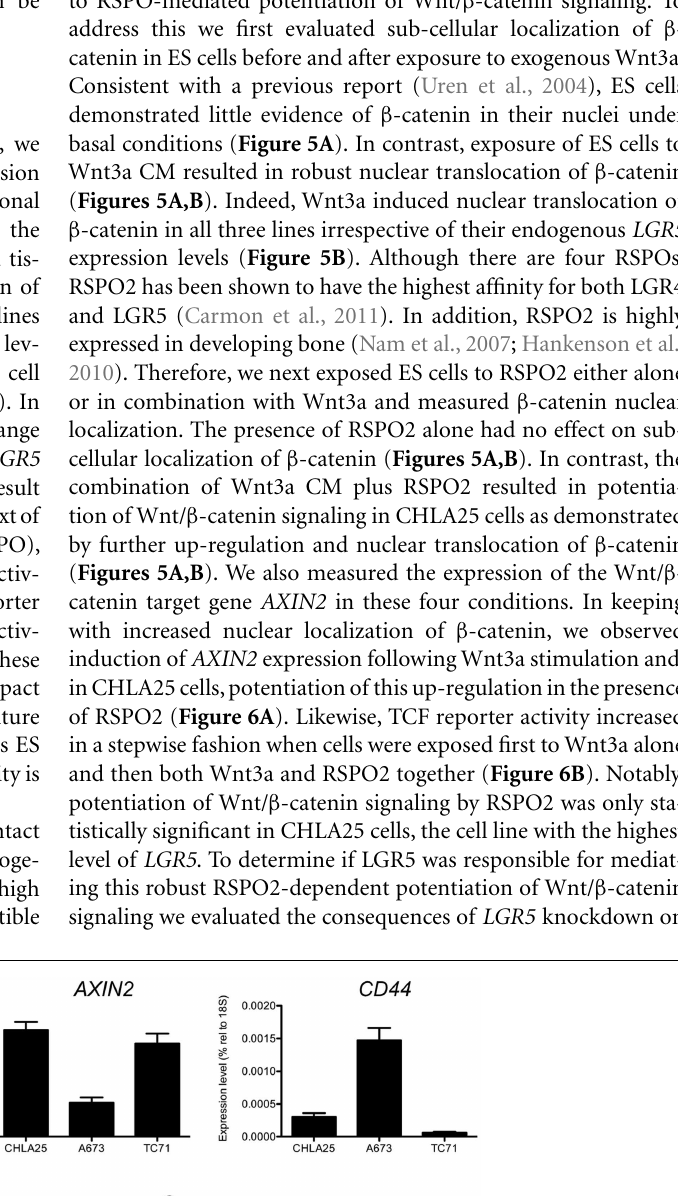
FIGURE 4 | No correlation exists between LGR5 expression and Wnt/ β -catenin activity in ES cells in standard culture. (A) Canonical Wnt/ β -catenin target gene expression was measured by qRT-PCR in ES cell lines.There was no apparent correlation between LGR5 expression and Wnt/ β -catenin target genes AXIN2 and CD44 . (B) No consistent or significant change occurs in the expression of a panel ofWnt/ β -catenin target genes